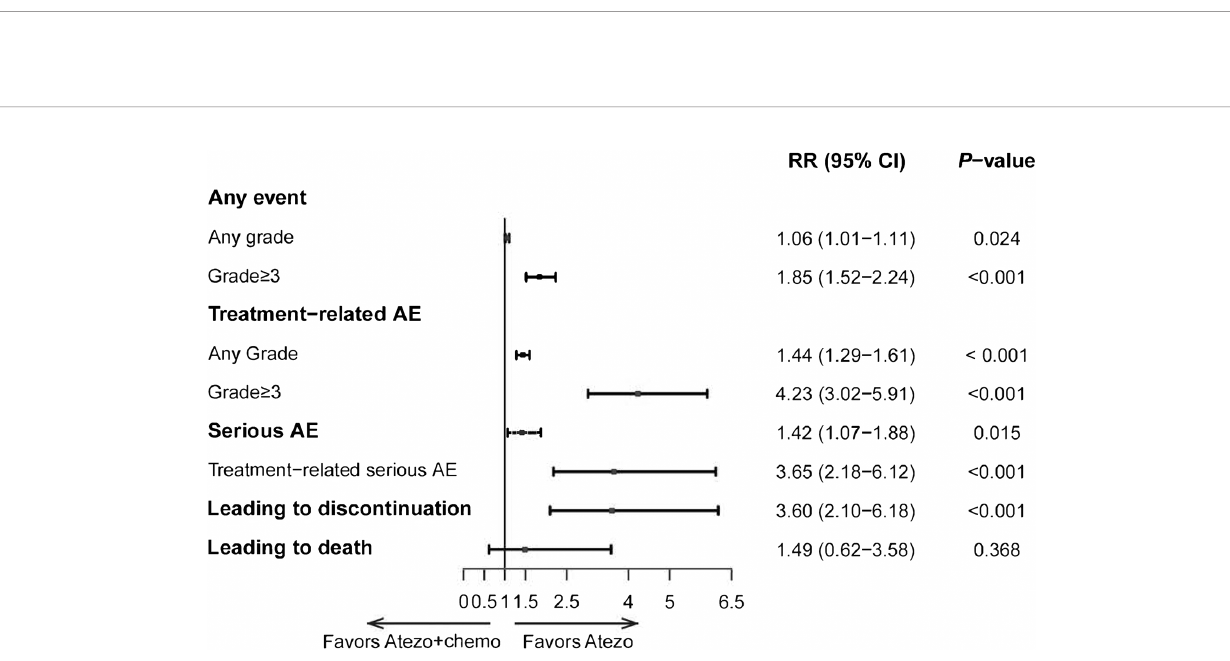
FIGURE 2 | Direct comparisons and indirect comparisons of ef fi cacy between Atezolizumab (Atezo) plus chemotherapy versus Atezolizumab for patients with high PD-L1 expression. (A – C) showed the forest plot of RR and HR directly comparing ORR (A) , PFS (B) , and OS (C) between Atezo plus chemotherapy or Atezo alone. The size (square) of the data marker corresponds to the weight of the study in the meta-analysis. The horizontal line across the square represents 95% con fi dence interval (CI). Based on the meta-analysis, the diamond represents the overall effect of the estimation. (D) showed the results of indirect analysis for ORR, PFS, and OS between Atezo plus chemotherapy and Atezo. Solid lines represented the existence of direct comparisons between treatment regimens, while the dotted line represented the indirect comparison between Atezo plus chemotherapy versus Atezo. All statistical tests were two-sided.